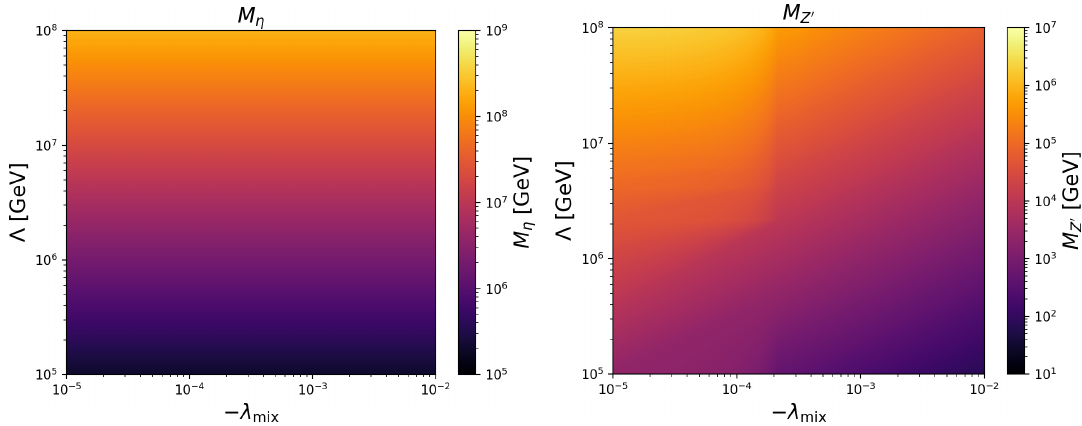
Figure 4 . The left contour represents the mass of η field, M η . The mass of Z 0 boson, M Z 0 , is shown on the right panel. Both contours are generated by using relevant parameters as following, Λ = Λ 0 , κ = κ 0 = 10 − 5 , φ 0 = 10 3 , h h i = 246 and m h = 125 GeV. Note that the coupling g X = 10 − 4 is applied.